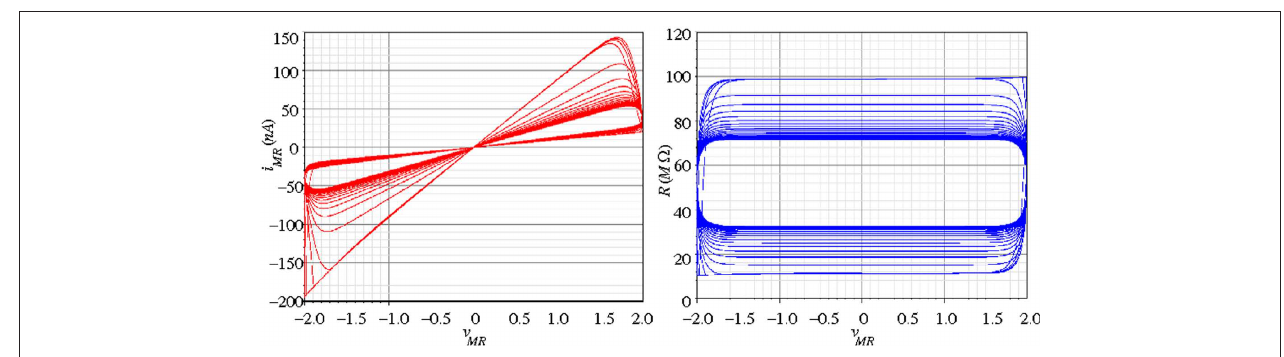
Figure 7 | Memristor simulations using the macro-model. Left, i/v curves obtained. Right, dependence of memristor time varying resistance with memristor